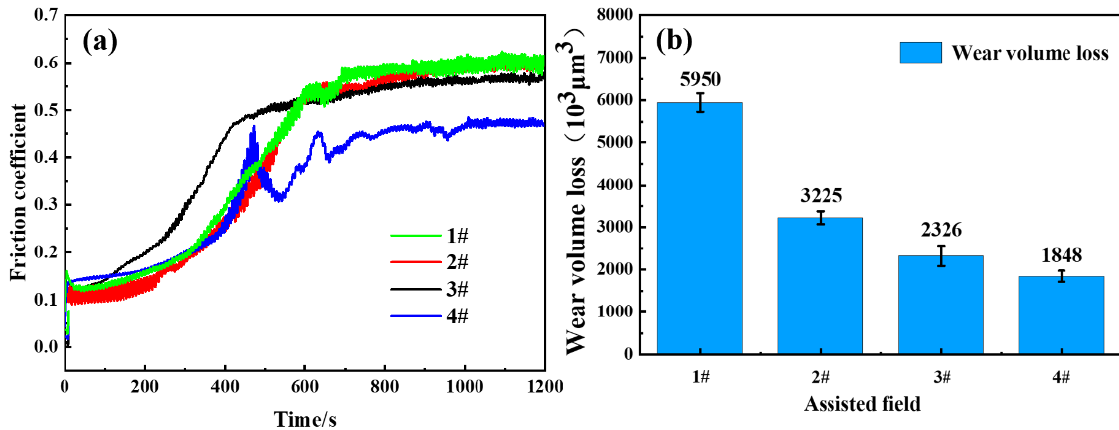
Figure 6. The friction properties of cladding coating under different field-assisted types, ( a ) Friction coefficient curve and ( b ) wear volume loss.